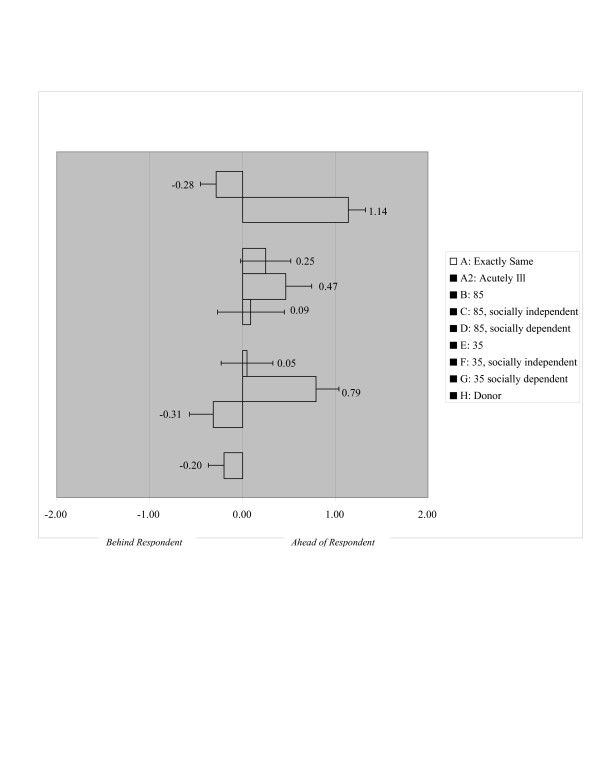
Unadjusted survey responses for scenarios A-H, compared to survey respondent's place in queue.